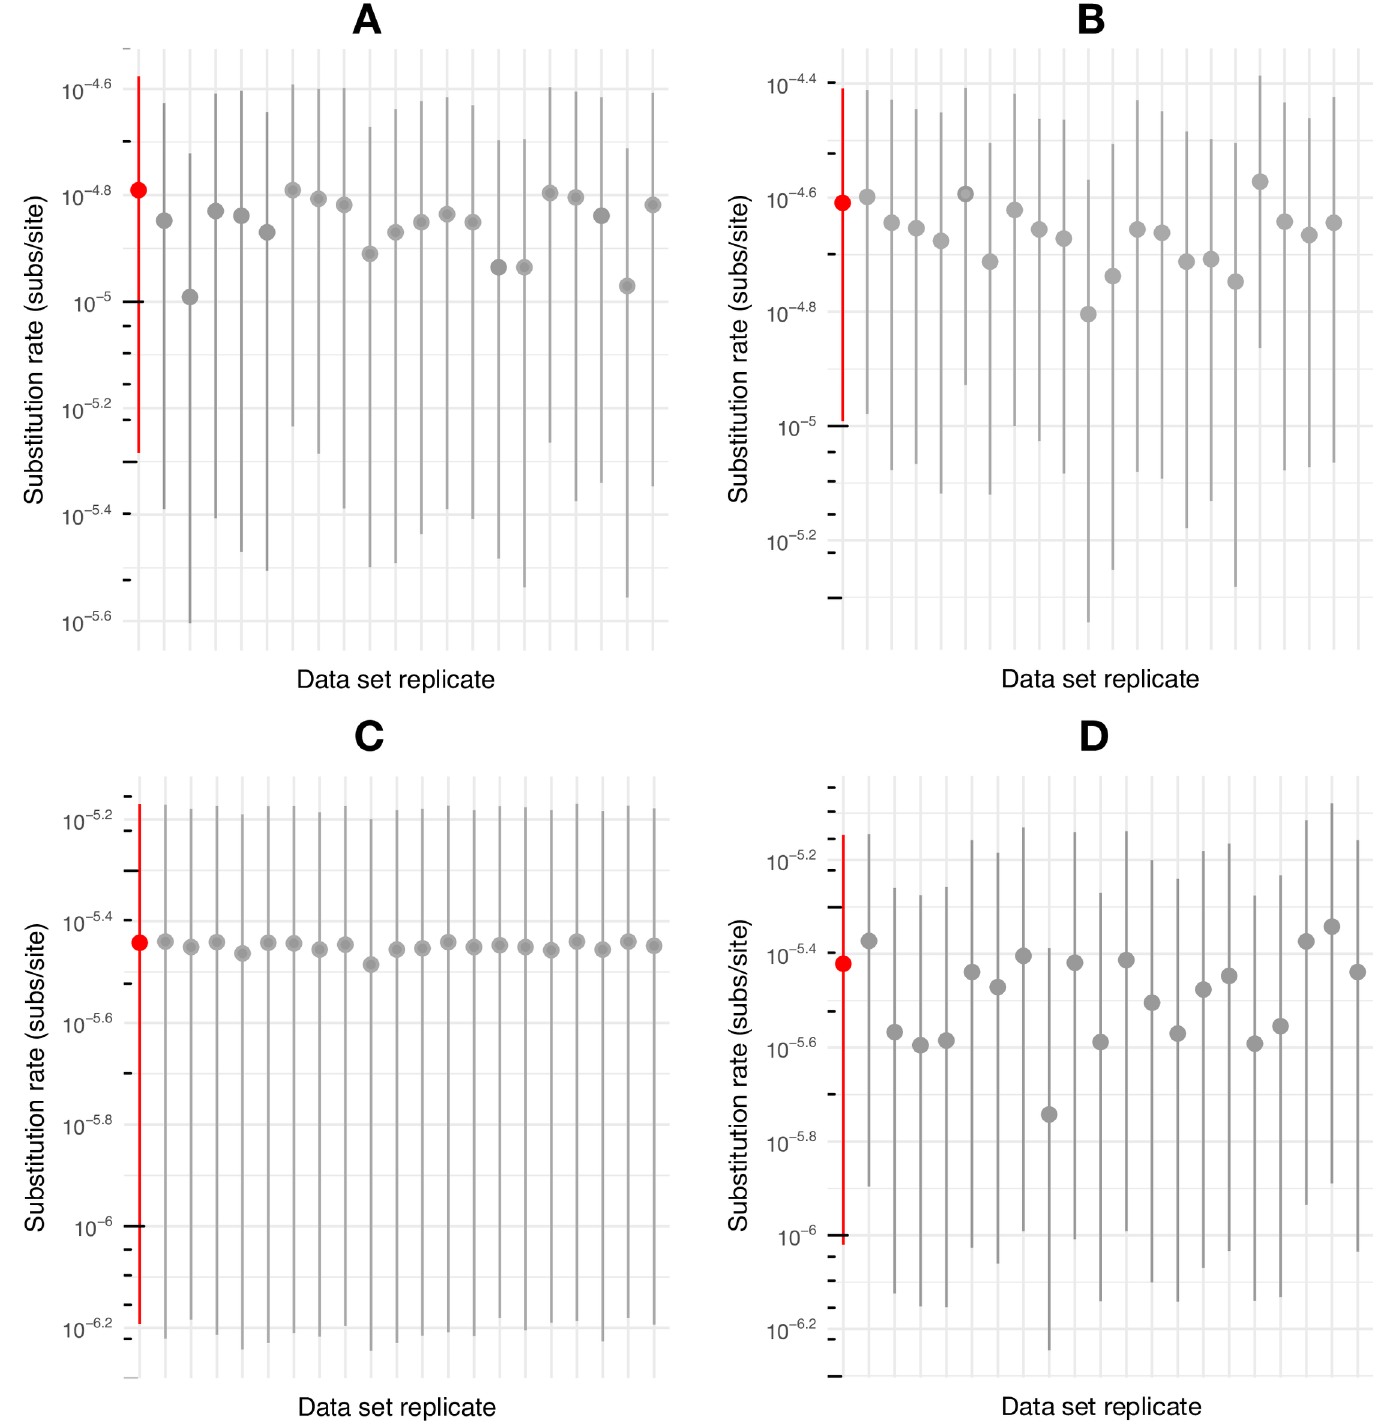
Fig 6. Date randomization test. Estimates of the nucleotide substitutionrate (subs/site/year) for the date-randomized subsets of HBV sequencesreflecting either all genotypes(a) or only D genotype(b). The y-axis indicatesthe substitutionrate (log 10 scale) and the x-axis shows different randomizations of each data set, with the non-randomized data set (i.e. with dates correctly assignedto sequences) coloredin red. The circles represent the mean rate estimates and the error bars show the 95% credibleintervals. (A) Modern HBV samplesonly (subset a). (B) All modernand the ancient HBV samples (subset a-ii). (C) All modern genotypeD samples (subset b). (D) All moderngenotypeD samples with NASD24SEQ included(subset b-i).